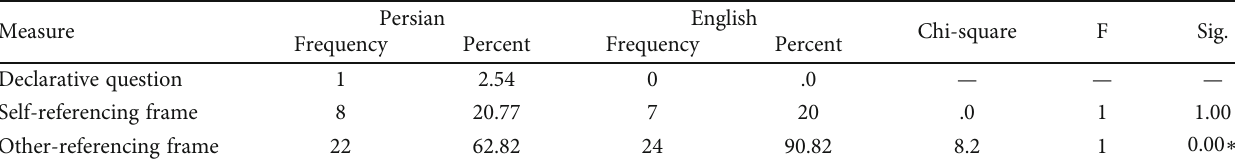
Table 5: The frequency distribution of referencing frames in English and